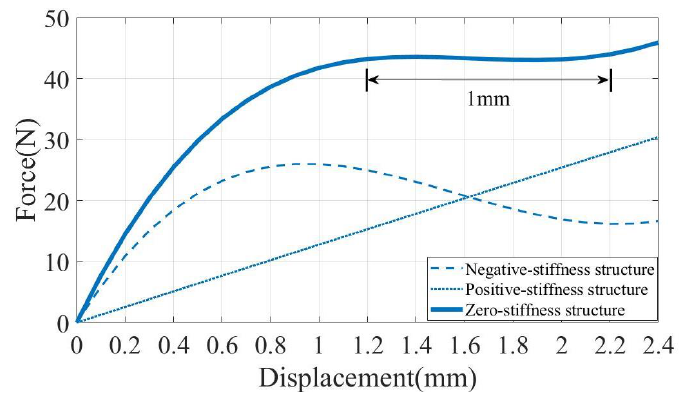
Figure 8. Analytical model results of the CFM.